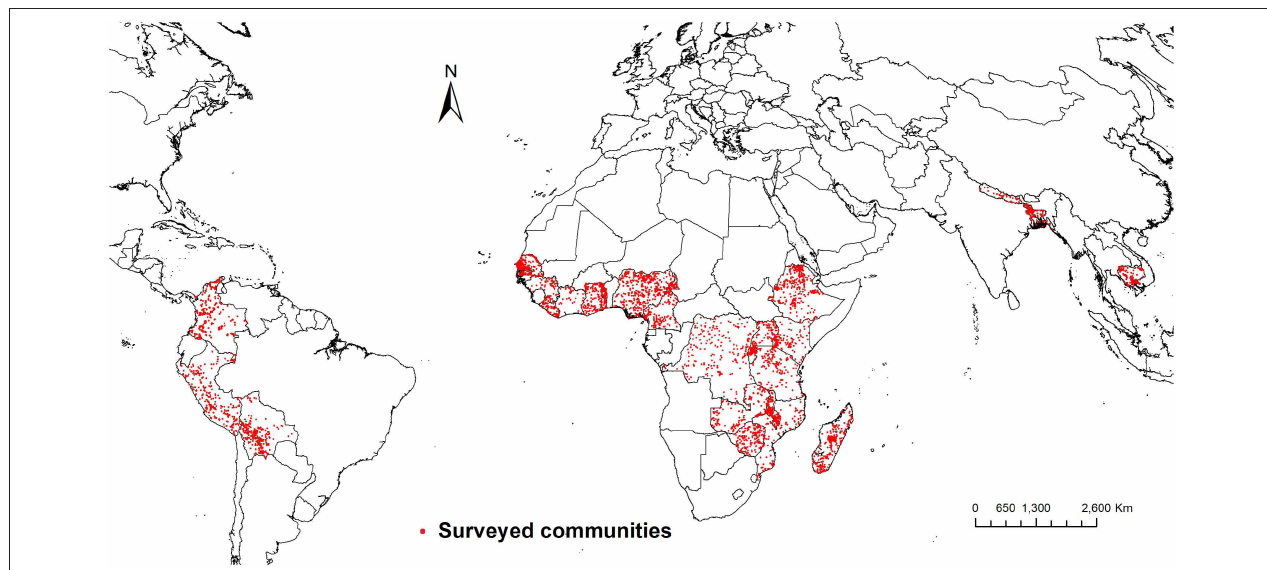
FIGURE 2 | Communities included in the estimation of effects of forest on child stunting. Data are from the Demographic and Health Surveys (DHS) program of the [United States Agency for International Development (USAID), 2018].